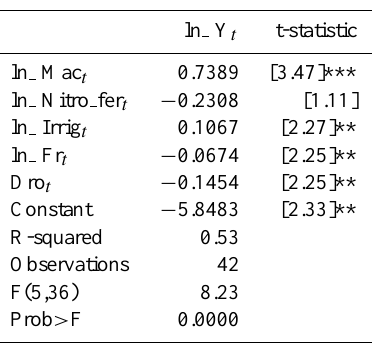
Table 8. Estimated coefficients of the crop production function for rice production.